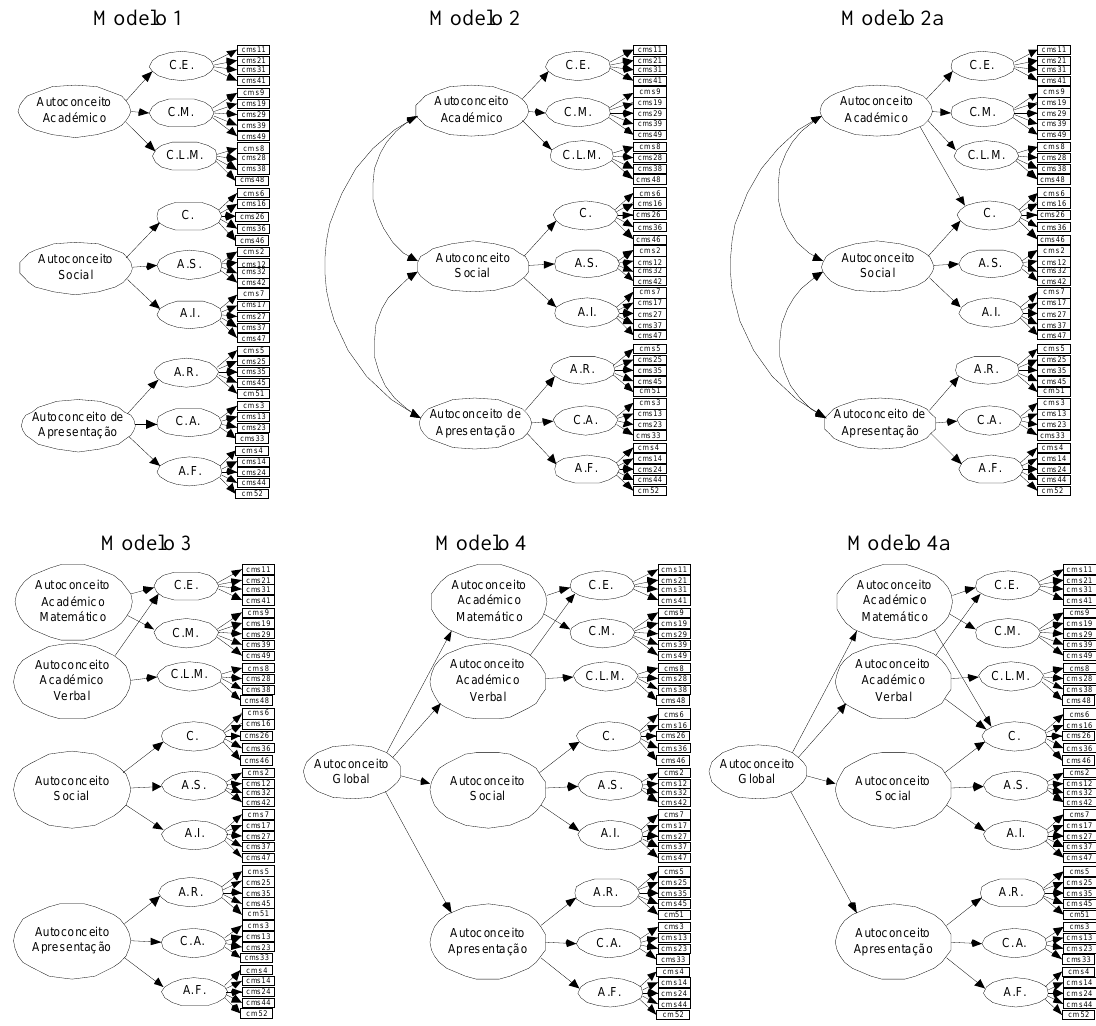
Figura 1 . Modelos submetidos a análise factorial confirmatória para testar a hierarquia do autoconceito. Nota . CE – Competência Escolar, CLM – Competência a Língua Materna, CM – Competência a Matemática, C – Comportamento, AS – Aceitação Social, AI – Amizades Íntimas, AR – Atracção Romântica, AF – Aparência Física, CA – Competência